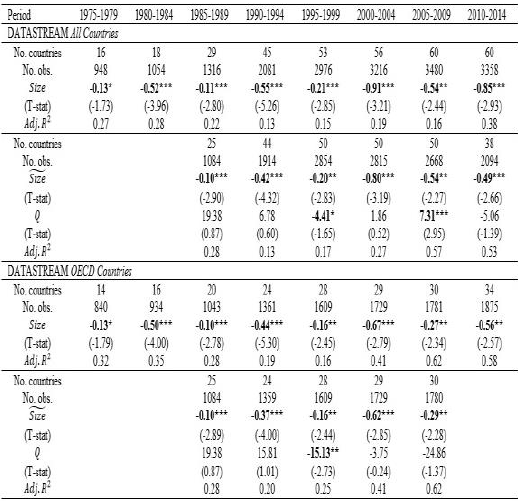
Table 7: Size Effects, Panel Data Regressions,